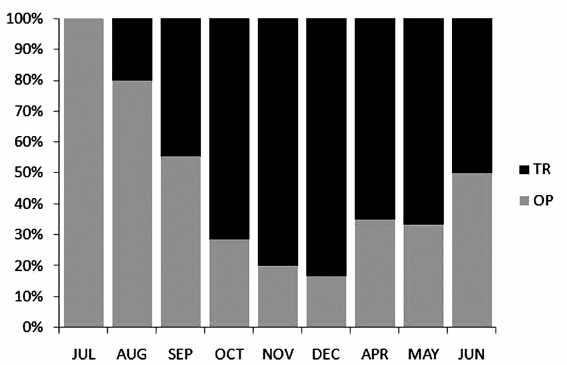
Fig . 7. – Annual variation pattern of the percentage of the opaque (OP) and translucent (TR) edges of Labrus mixtus otoliths sampled between April and December 2009.